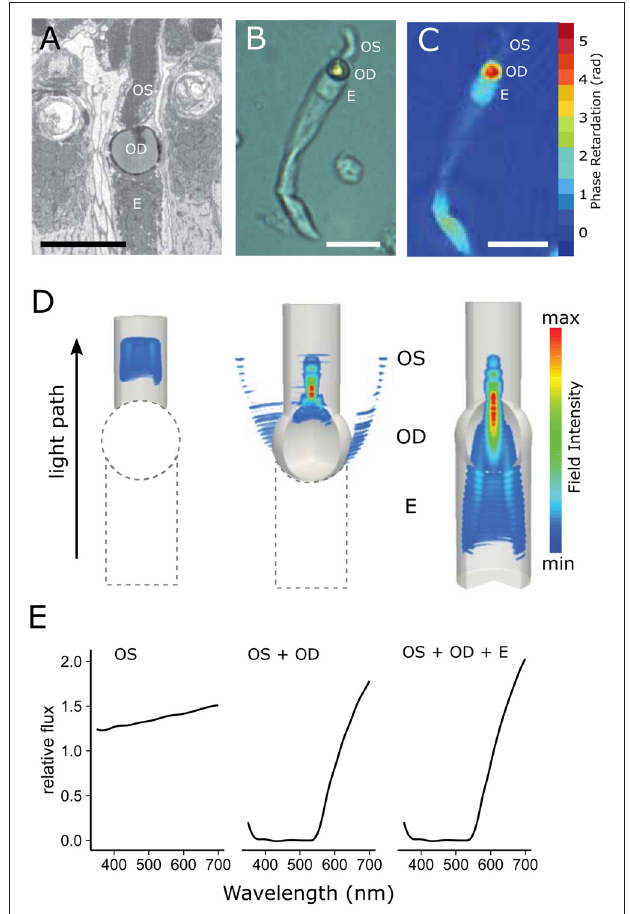
FIGURE 5 | Cone oil droplets enhance light capture by the outer segment. (A) An electron micrograph of a chicken cone photoreceptor shows that the cone oil droplet (OD) is located at the inner and outer segment (OS) interface immediately adjacent to the ellipsoid (E). (B) An isolated MWS single cone from the chicken under bright field illumination. (C) The same cell imaged with digital holographic microscopy to map the phase retardation of light through different portions of the cell. Phase retardation correlates with the refractive index of the various subcellular compartments. (D) Finite-difference time-domain (FDTD) simulations of light (550 nm) propagation through three configurations of the LWS cone photoreceptor (left = outer segment alone; middle = outer segment + oil droplet; right outer segment + oil droplet + ellipsoid). Note that there is considerable scattering of light at the droplet interface (middle panel), but that when the droplet is combined with the ellipsoid, scatter is reduced and flux to the outer segment is enhanced (right panel). (E) The predicted flux of light to the outer segment for the three configurations of the photoreceptor. The addition of the oil droplet dramatically reduces flux due to the spectral absorbance of the droplet at shorter wavelengths and light scattering across much of the spectrum, but modestly enhances flux at longer wavelengths. This figure has been modified with permission from Wilby et al. (2015).